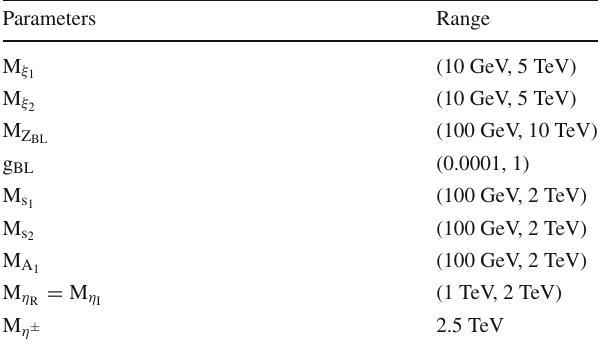
Table 3 The parameters of the model and ranges used in the random scan Parameters